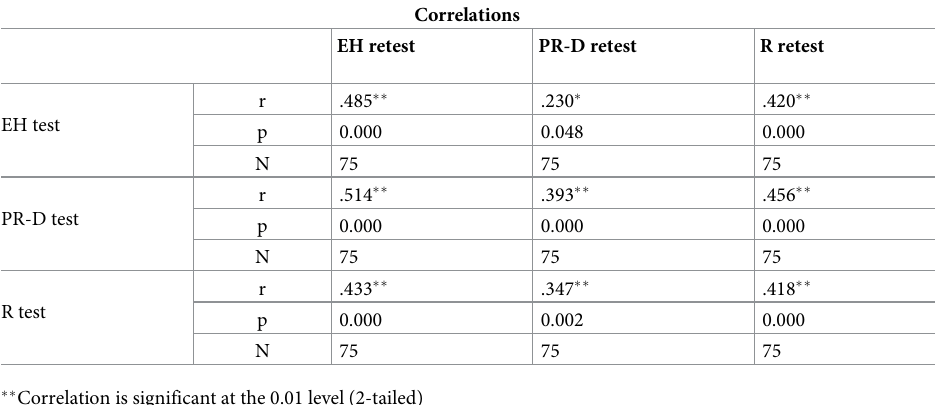
Table 4. Correlation of test and retest results.